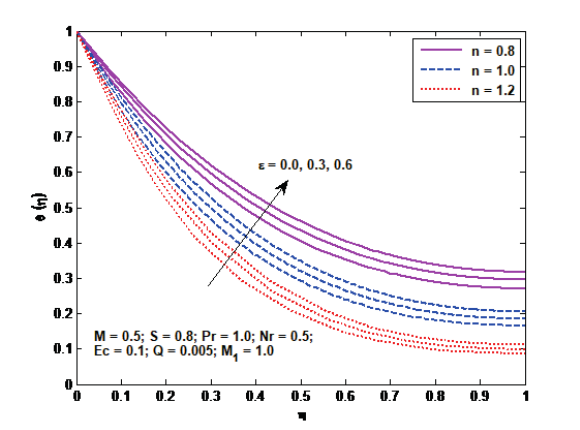
Fig. 14: Temperature profiles for different values of